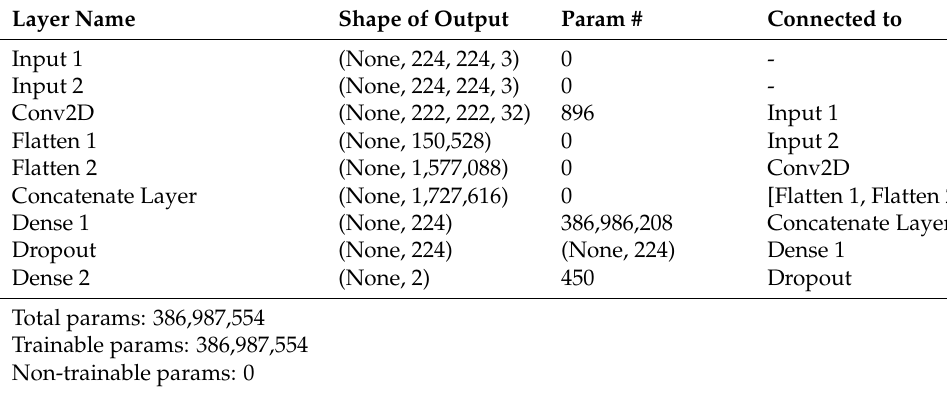
Table 1. Summary details for DICNN